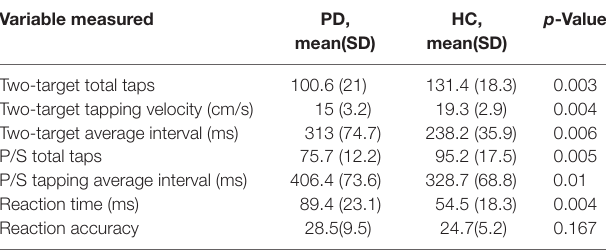
tABLe 1 | Summary of significant results (univariate analysis). variable